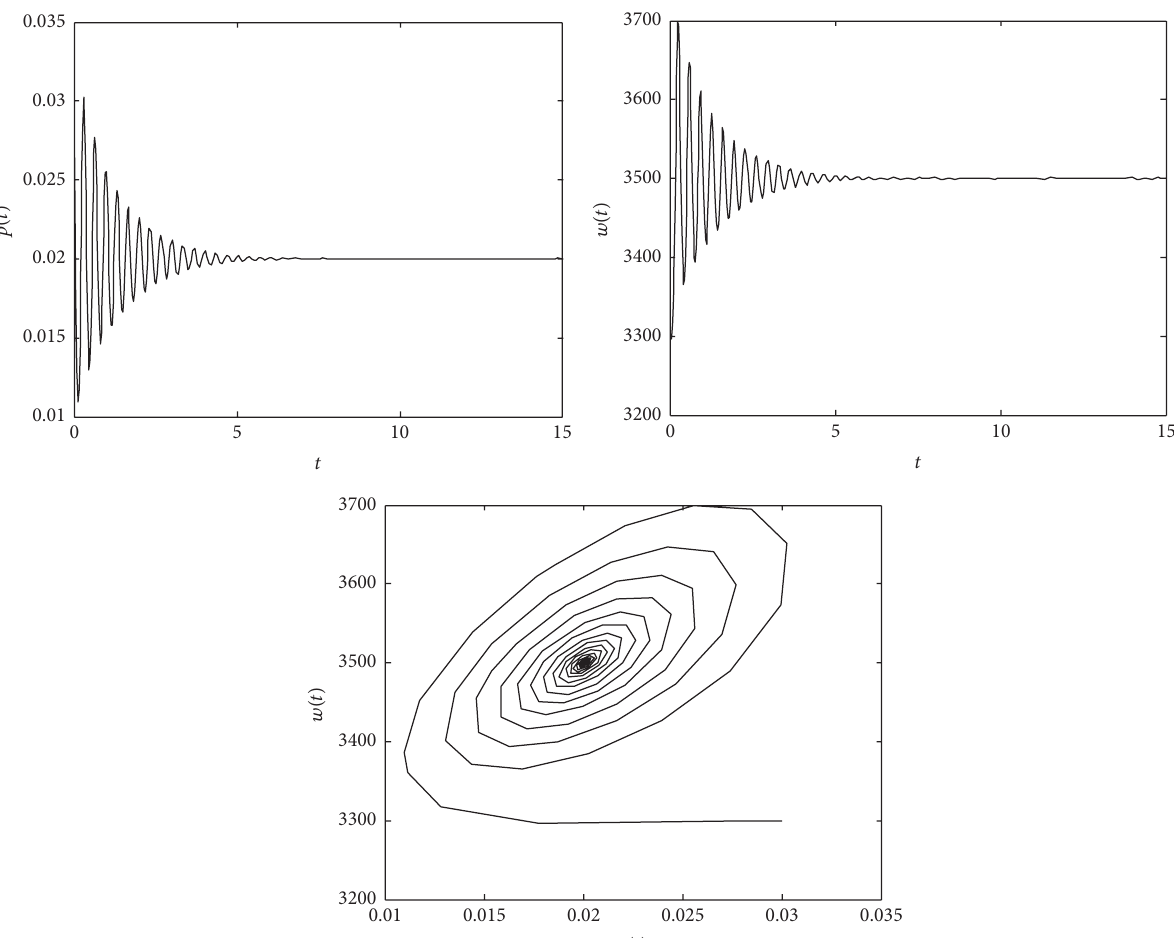
Figure 3: State plot and phase plot of state feedback controlled system (5) with 𝛼 = 1000 and ℎ 1 = 0.8 , ℎ 2 = 0 , and ℎ 3 = 0 .